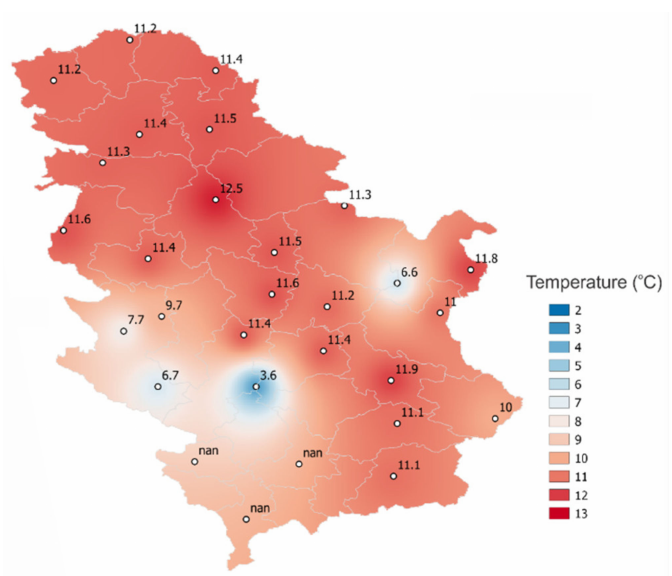
Figure 3. Annual temperatures at Serbian climate stations (1981–2010) (Source: RHMS